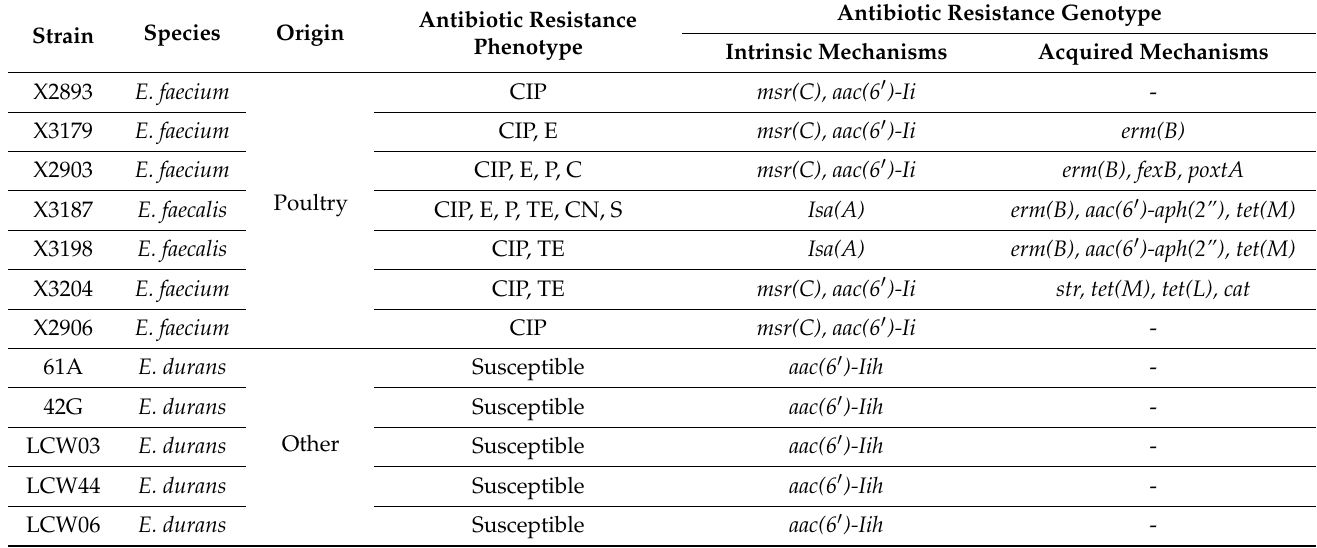
Table 4. Antibiotic resistance phenotype and genotype of the BP+ enterococci.